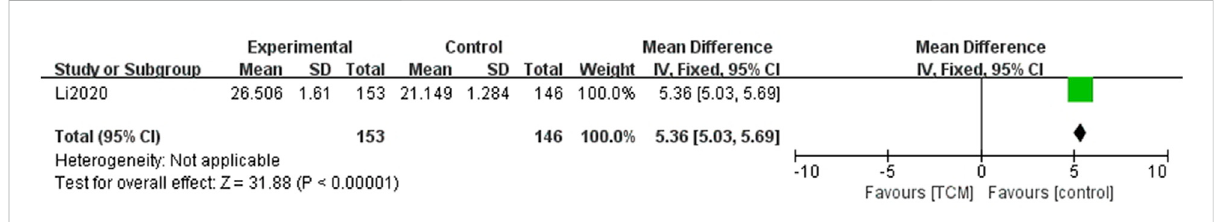
FIGURE 6 Forest plots and subgroup analysis for comparison of PFS between TCM group and control group.